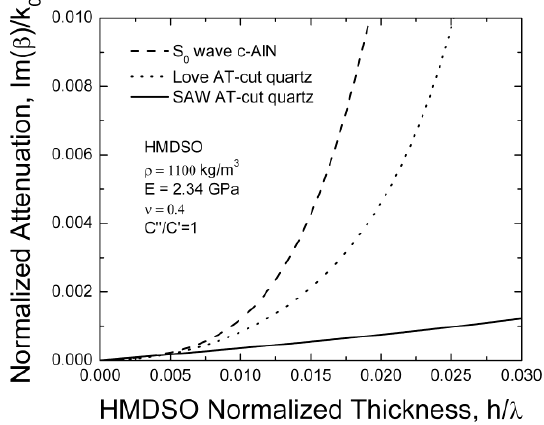
Figure 4. Attenuation of RSAW, Love and S0 waves. β-complex wave number, k0-real